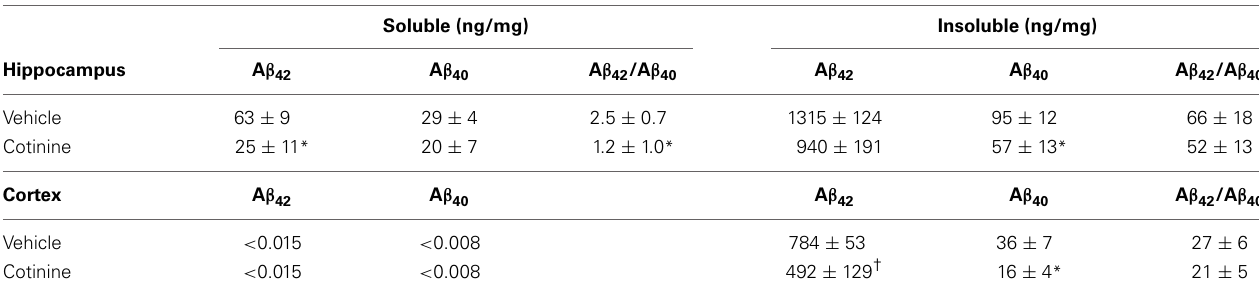
Table 1 | Levels of soluble and insoluble A β in the hippocampus and frontal cortex of Tg6799 mice. Soluble (ng/mg)